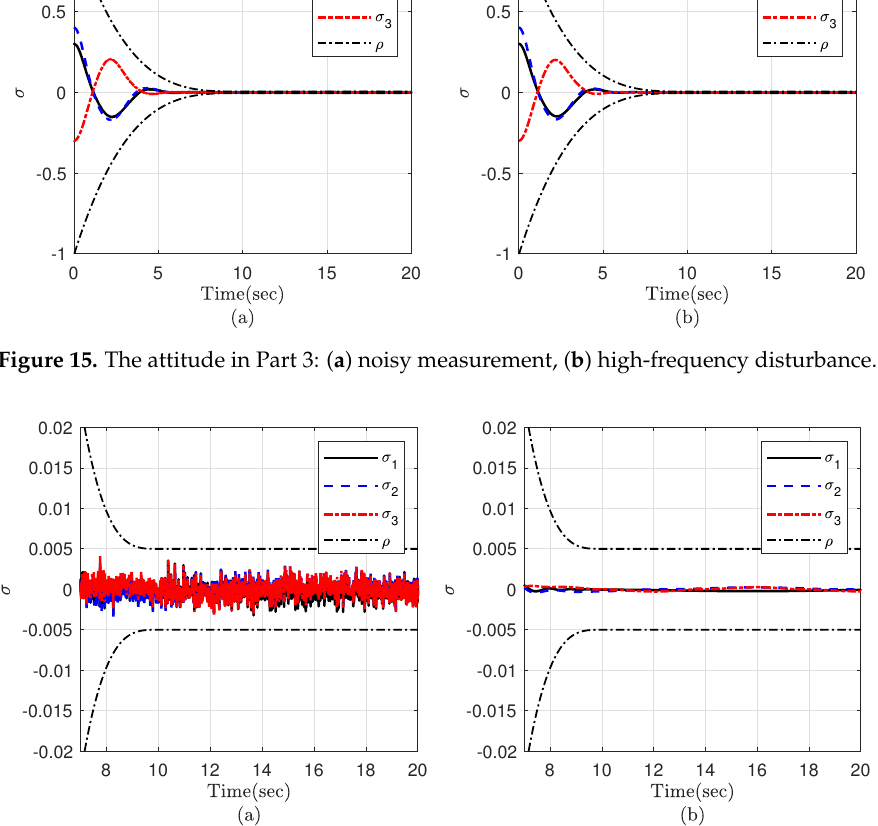
Figure 16. The attitude in Part 3 in steady state: ( a ) noisy measurement, ( b ) high-frequency distur- bance.